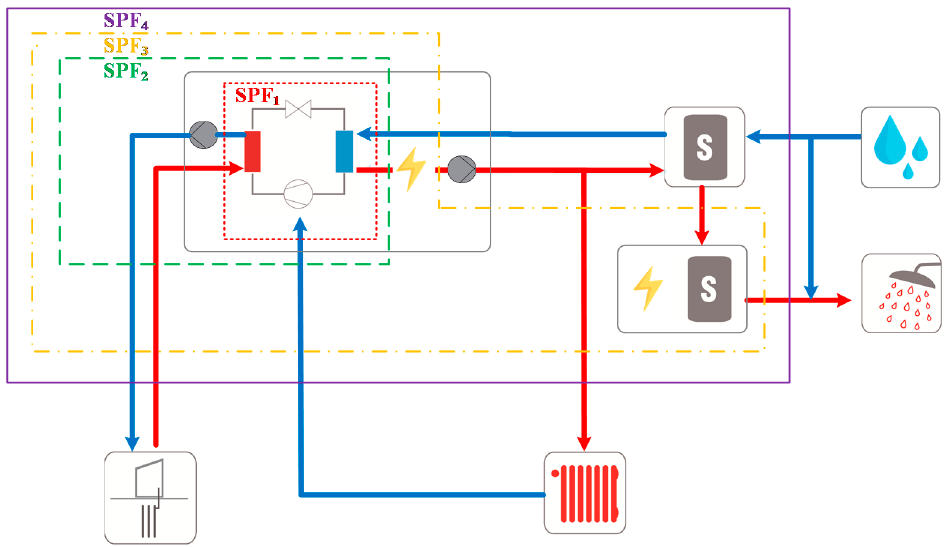
Figure 5. SEPEMO boundary scheme applied to the clubhouse GSHP system. Pictograms in drawing used with permission from TU Braunschweig IGS. Table 3. Formulas to calculate the seasonal performance factors based on the SEPEMO boundary scheme.